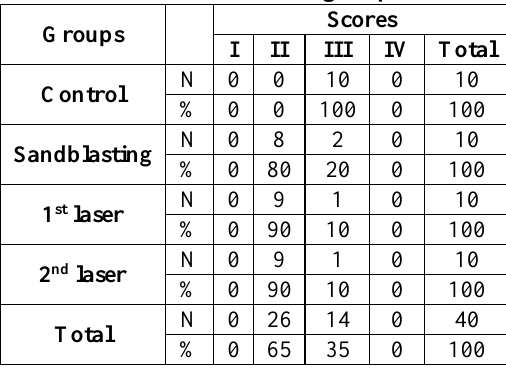
Table 2: Comparing the shear bond strength between each two groups using Tukey HSD test Mean Groups p-value Difference Control